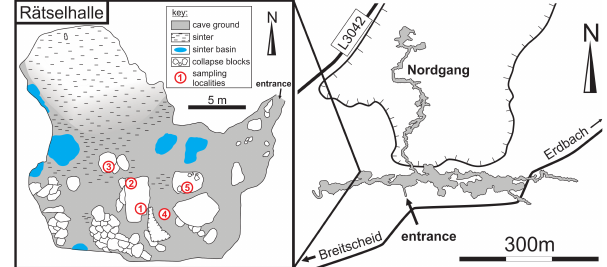
Fig. 2. Sketch map of Herbstlabyrinth-Advent Cave system show- ing the location of R¨atselhalle as well as a speleological map of this chamber with sampling